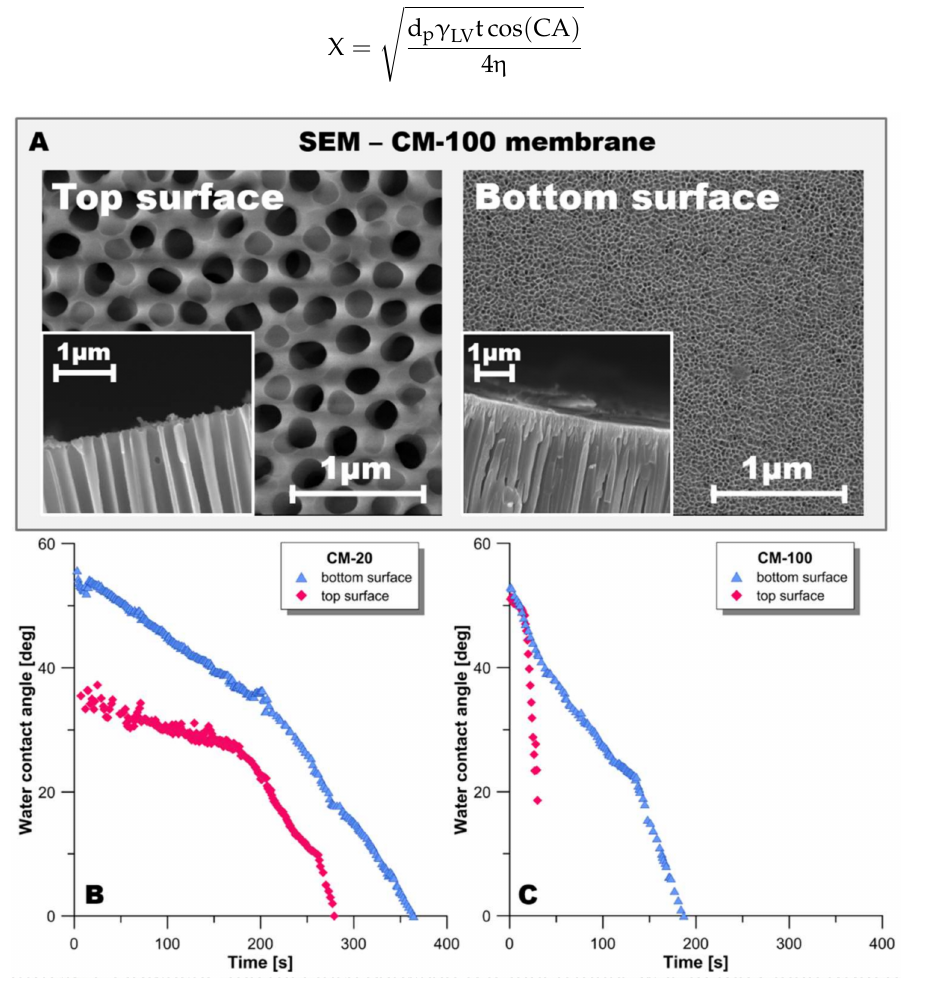
Figure 1. ( A ) SEM images of top and bottom sides of the pristine 100nm CM-100 membrane. Dynamic contact angle (CA) measurements on CM-20 ( B ) and CM-100 ( C )